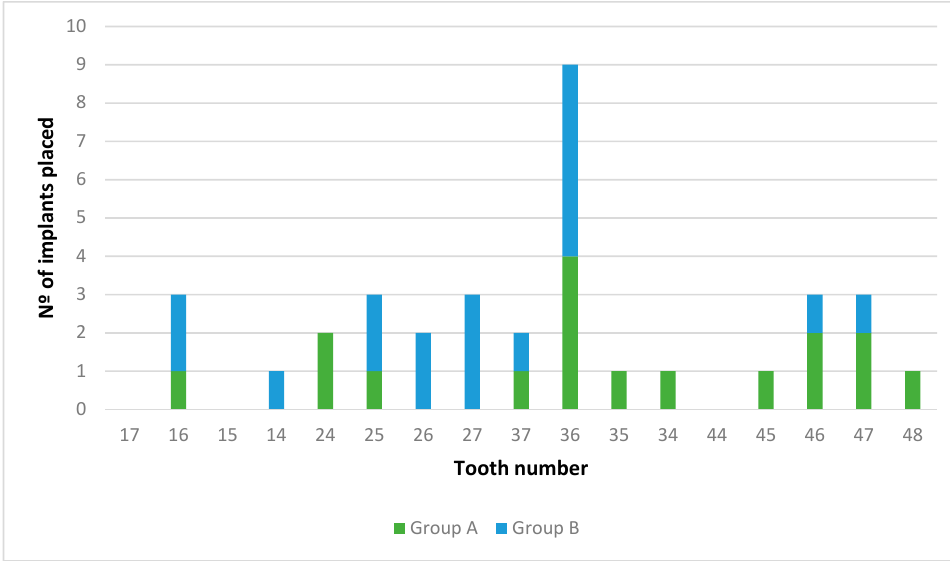
Figure 3. Study sample flow-chart.